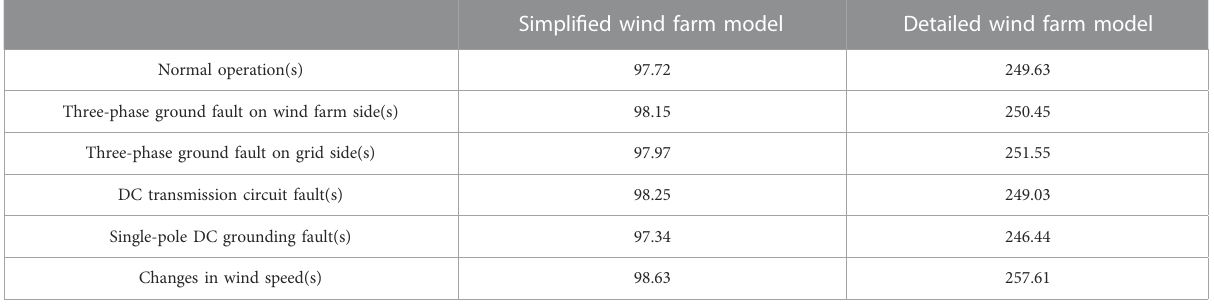
TABLE 5 Comparison of the simulation